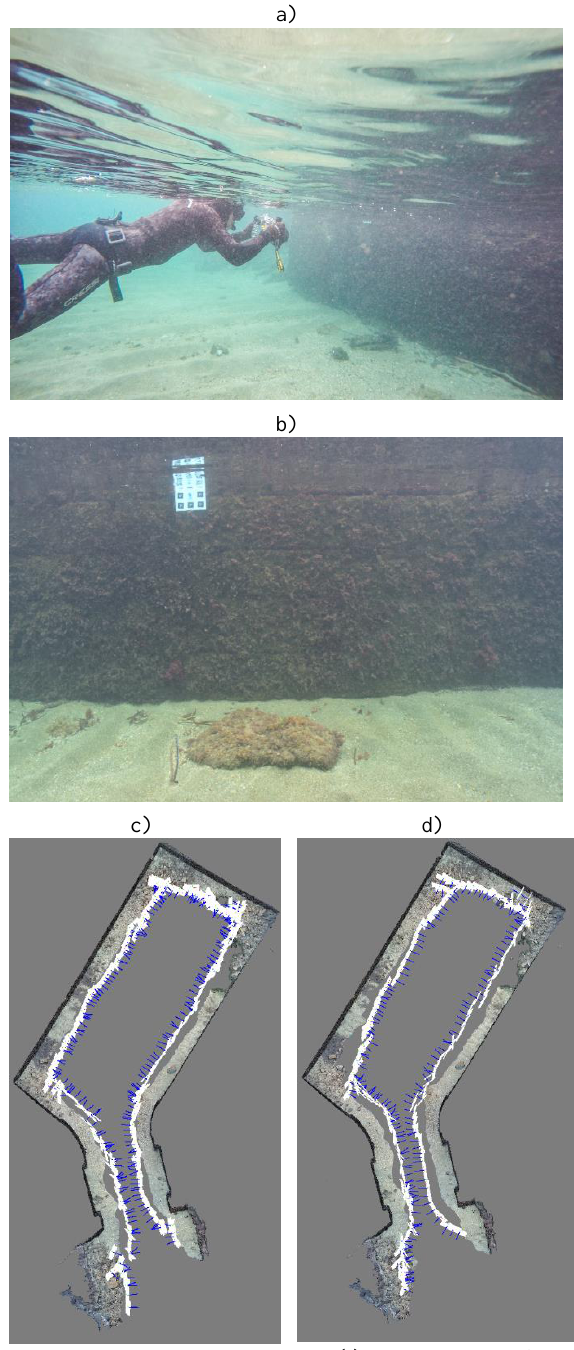
Figure 10. Underwater image acquisition (a) and a sample image from the dome port (b). Final camera networks for the dome port (c) and flat port (d).